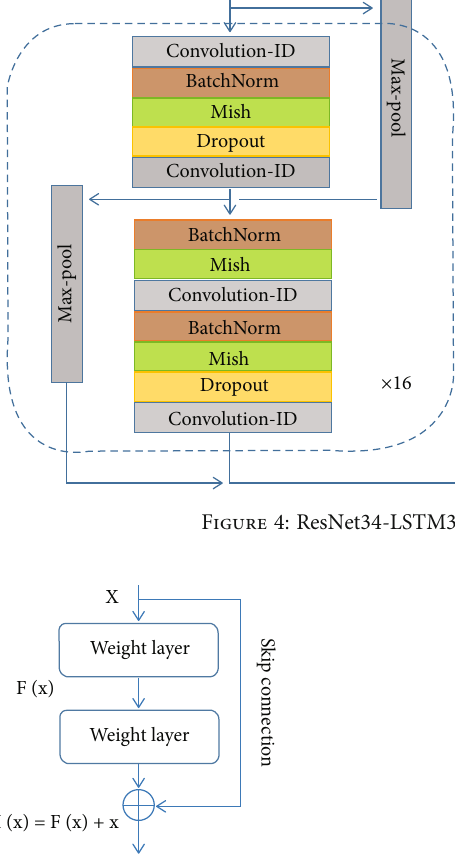
Figure 5: Residual structure